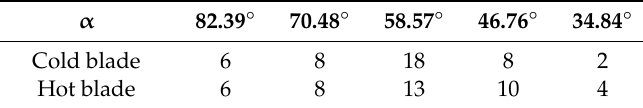
Table 4. Number of damaged elements.